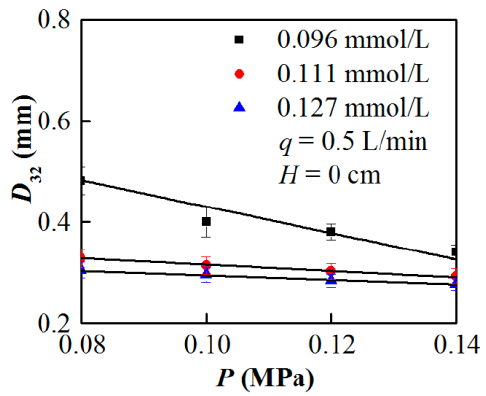
Figure 9. D 32 as a function of feeding pressure ( P ).